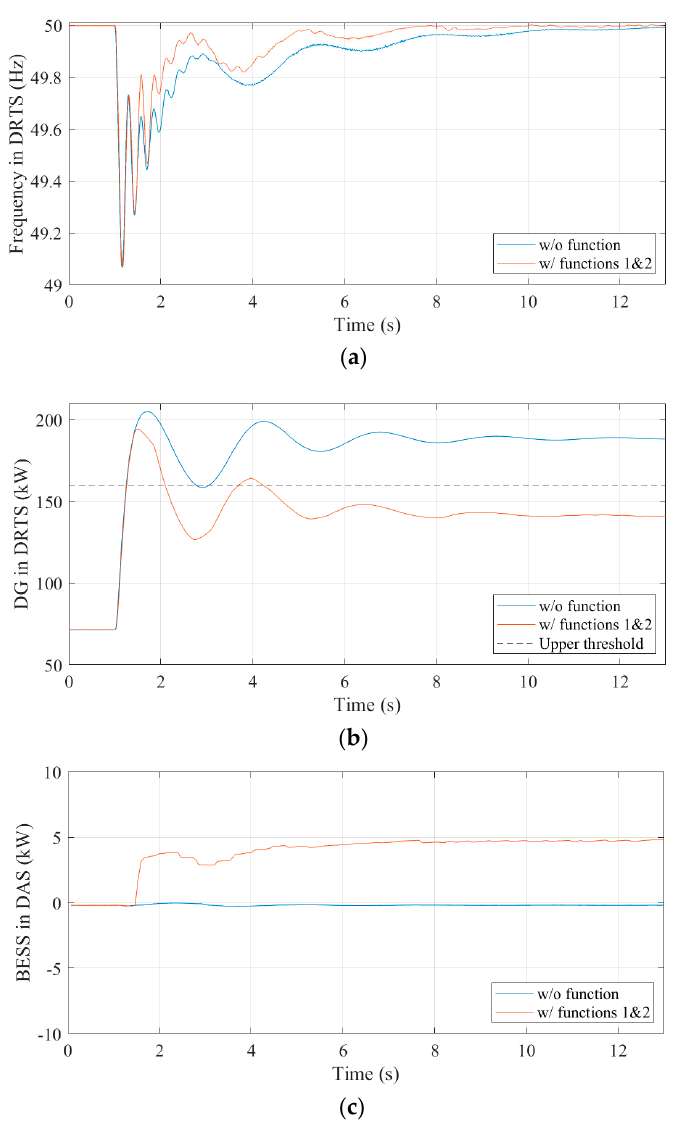
Figure 8. Test results when functions 1 and 2 are activated (load increase from 7 kW to 19 kW): ( a ) frequency; ( b ) DG set output; ( c ) battery output. Note that 10 times scaled measurement of actual lab